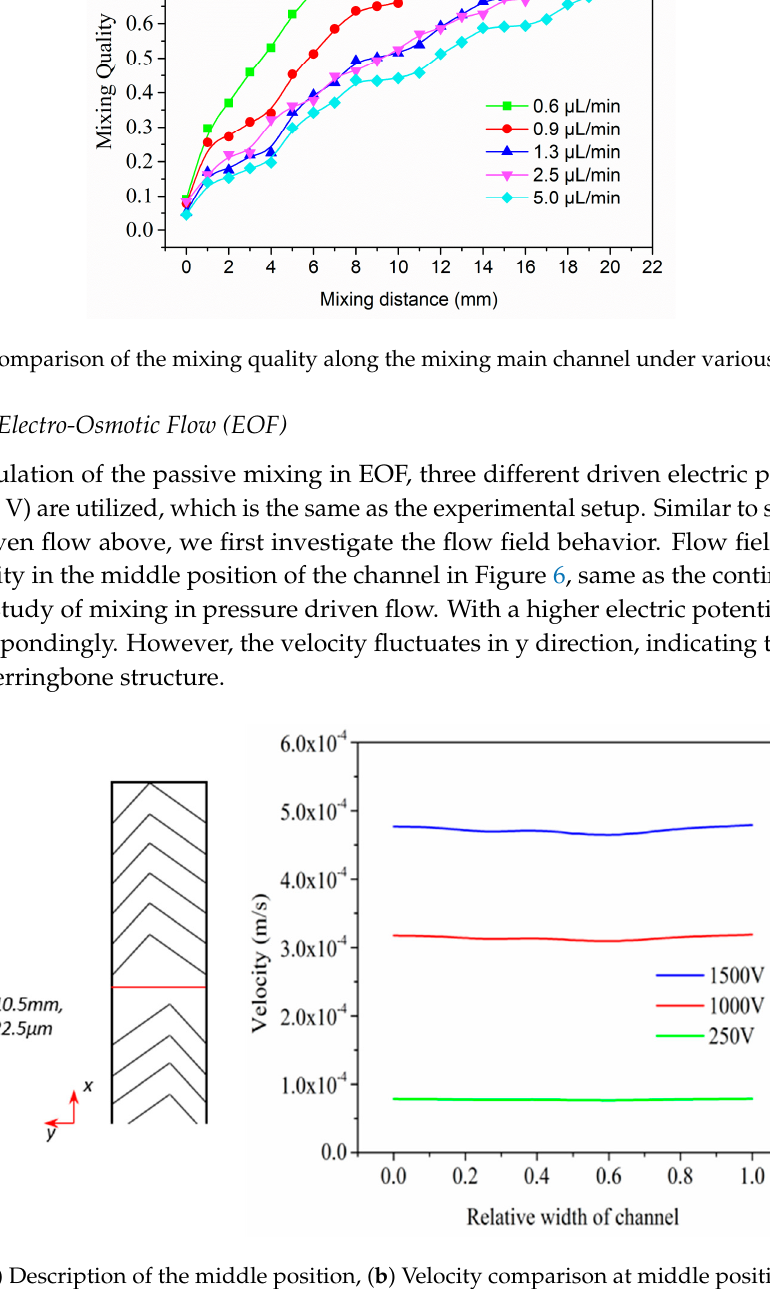
( c ) Figure 4. The concentration profiles along the main channel for various Re , ( a ) ( Re = 0.0016); ( b ) ( Re = 0.0035); ( c ) ( Re = 0.014). The uniformity of the color represents the mixing performance. Figure 5 further illustrates the effect of flow rate on mixing performance. Mixing quality along the mixing main channel for different flow rate is compared. In general, the mixing behaves better, if the Re goes down. The mixing quality at 20 mm increases from 72.3% to 97.7% as flow rate decreasing from 5.4 μ L/min to 0.6 μ L/min, which is strictly close to the results in experimental research.